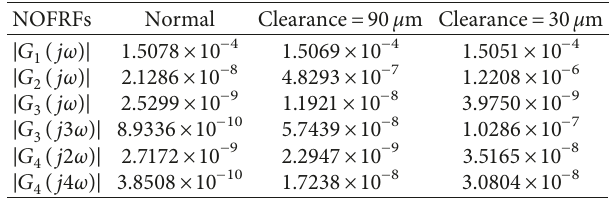
Table 3: The NOFRFs of rub-impact rotor system. Table 2: Simulation parameters of the rotor